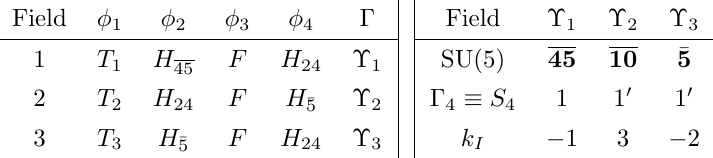
Figure 2 . The supergraph for dimension 5 operators in the superpotential of down quarks.